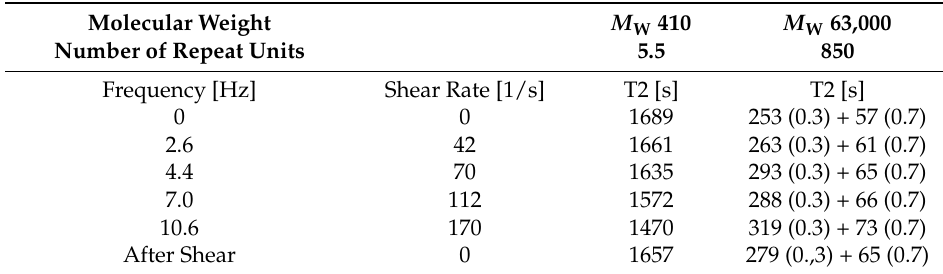
Figure 3. Results from Carr-Purcell-Meibom-Gill (CPMG) measurements of PDMS melts under shear. The insets indicate the shear rates applied in the Couette cell. On the left, the result for the sample of a molecular weight of 410 g/mole, and, on the right, the result for the sample of a molecular weight of 63,000 g/mol, are depicted. Below each figure the residuals from a mono exponential ( left ) or bi-exponential ( right ) fit to the experimental data acquired under the highest shear rate are depicted as a measure of the quality of the fit. Table 1. Summary of the multi-exponential fits to the decay curves. For the bi-exponential decay the respective fractions are quoted in